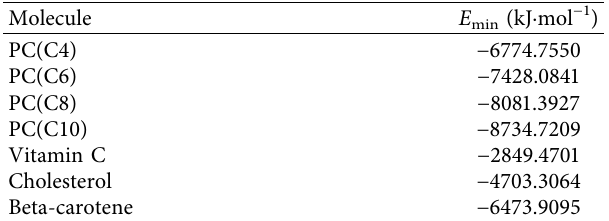
Table 1: Te minimum optimization energy ( E mized